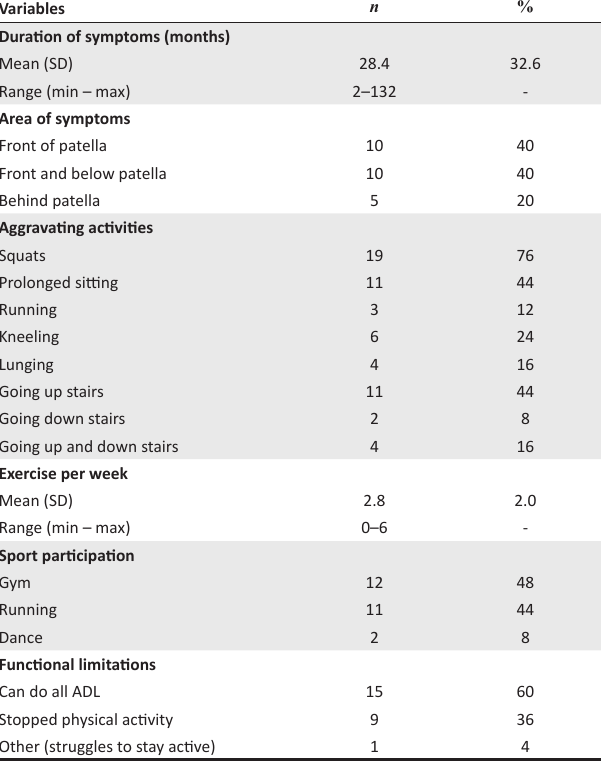
TABLE 2: Participant symptom presentation and activity level ( n =